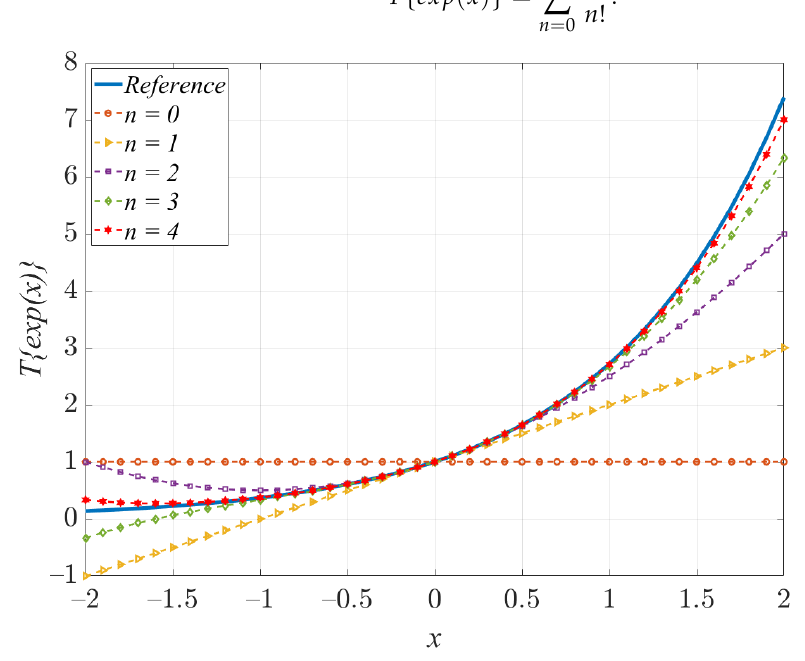
Figure 2. Exponential function and its Taylor series at